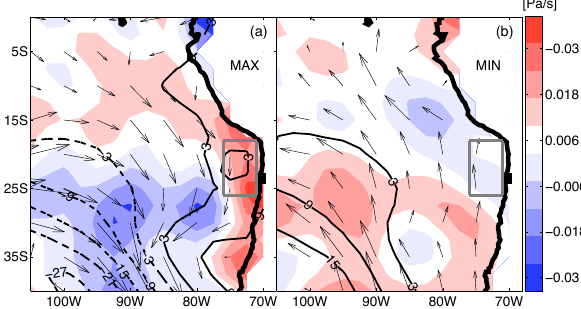
Figure 7. NCEP reanalysis anomalies at 850 hPa: Geopotential heights (contours), Fig. 7. NCEP reanalysis anomalies at 850hPa: Geopotential subsidence (dp/dt, colorscale), and winds, for (a) MAX N d composite, (b) MIN N d heights (contours), subsidence (dp/dt, colorscale), and winds, for composite. Antofagasta location indicated with a black box, and Arica Bight domain (a) MAX N d composite, (b) MIN N d composite. Antofagasta loca- contoured in grey. tion indicated with a black box, and Arica Bight domain contoured in grey.